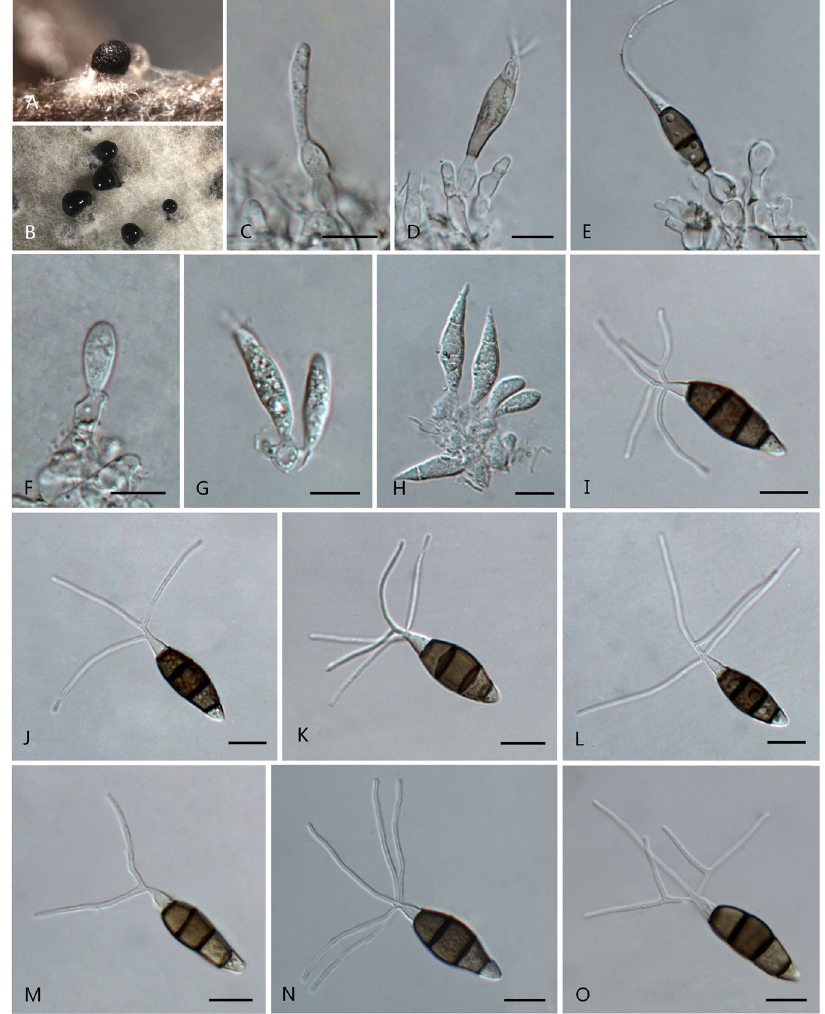
Figure 13. Pestalotiopsis yanglingensis ( A–E , M – O ) from ex-holotype culture CGMCC 3.18219 ( = LC4553), ( F – L ) from culture LC3372. ( A ) Conidioma sporulating on pine needle. ( B ). Conidiomata sporulating on PDA. ( C–H ) Conidiogenous cells and conidia. ( I–O ) Conidia. Scale bars = 10 μ